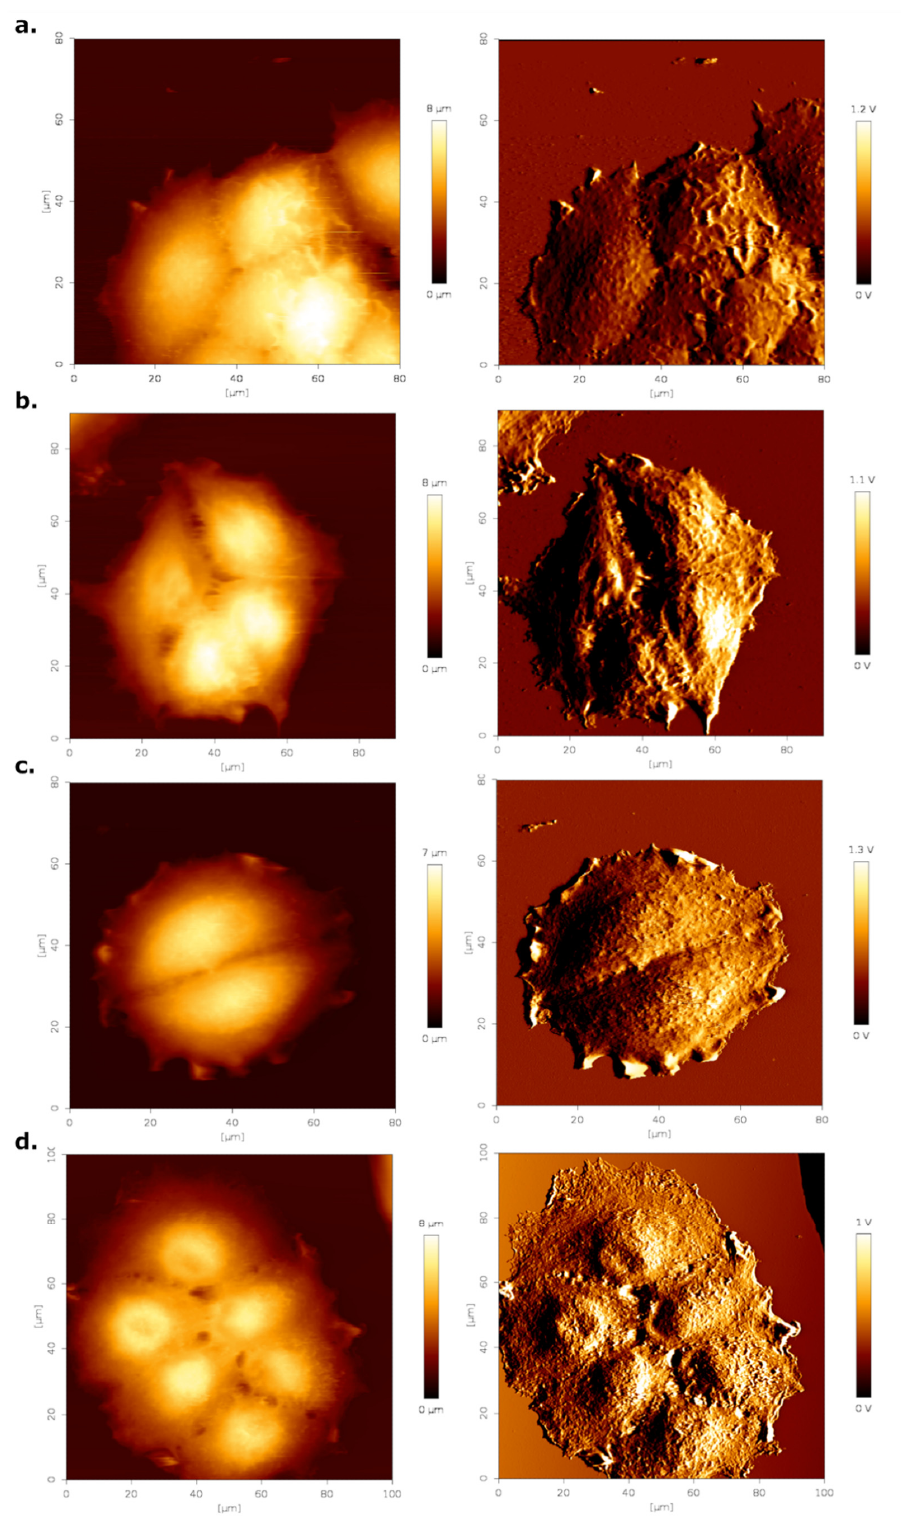
Figure 5. AFM contact mode images (height—left column, error—right column) of MCF-7 cells. ( a ) DMEM control, ( b ) DMEM treated with estrogen, ( c ) hormone-free medium control and hormone-free medium with estrogen ( d ). Measurements were performed in PBS at RT. Brighter pixel values correspond to a higher height/error value.